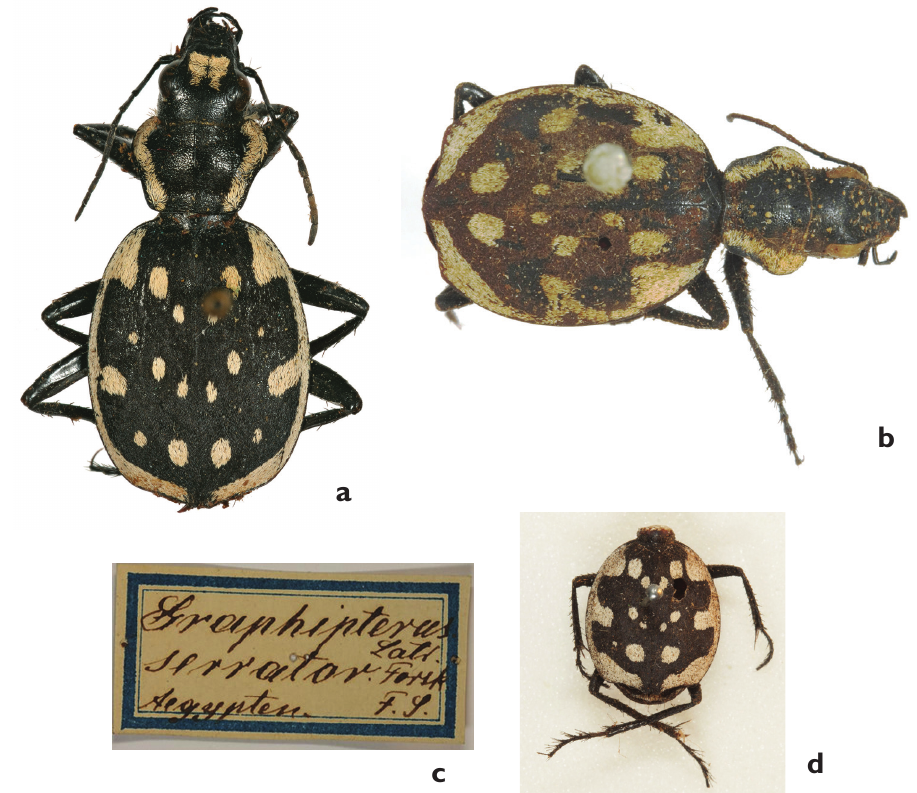
Stridulatory structure (ventrolaterally on elytral margin and carina on inner side of metafemur) present; pronotum posteriorly concave; median lobe of aedeagus with long curved tip or short, not curved tip (Fig. 9a–f, i–p) ........ 2 Stridulatory structure absent; pronotum posteromedially not concave; me- dian lobe of aedeagus with wide and flat tip (Fig. 9f, g) ............................ 15 White scales on pronotum restricted to lateral margin (Figs 20–24 except 20a, 20b); elytra and pronotum without grayish or yellowish scales; elytra with white spots and extensions well contrasted to the dark background ..... 3 Pronotum with white scales extending medially, sometimes to median line (Fig. 20a, b); elytra and pronotum often with grayish or yellowish scales; white spots and extensions on elytra not well contrasted to the dark